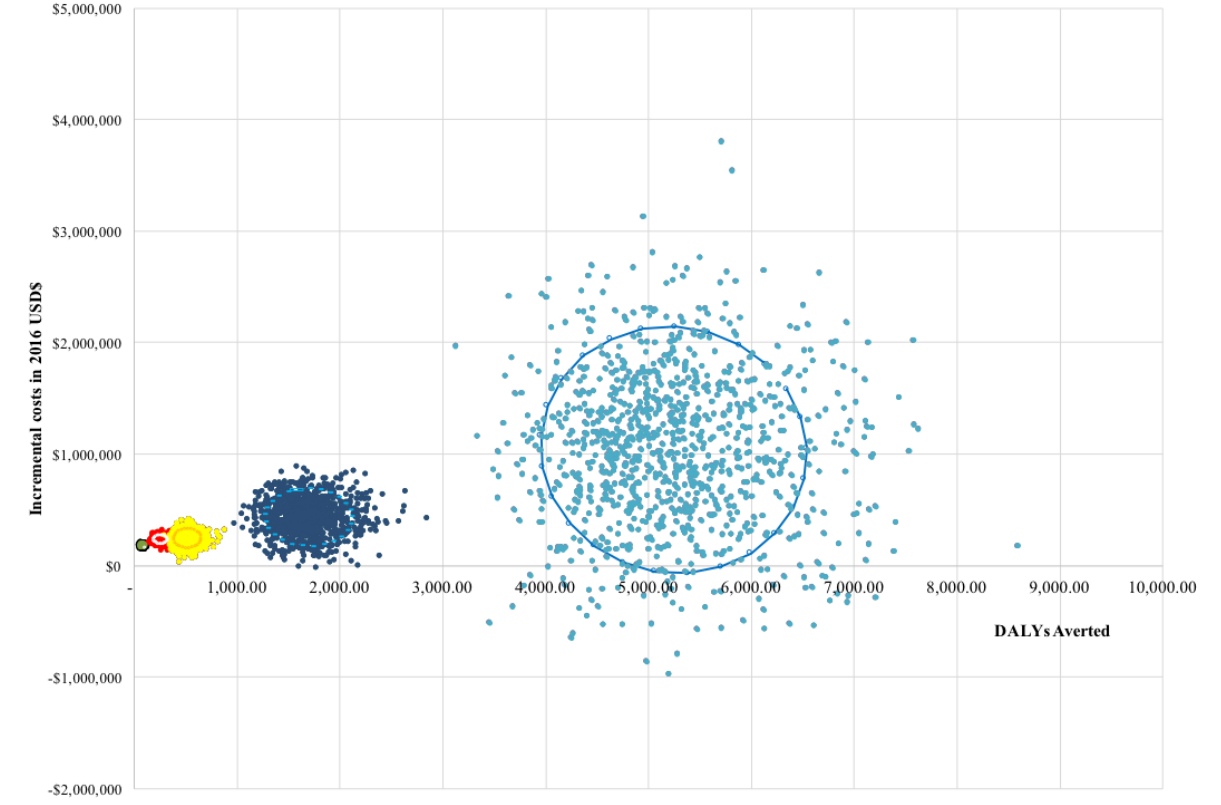
Figure 3. Cost effectiveness plane of years 1-5 of MAMA implementation vs. Status quo in Gauteng, South Africa. Individual dots represent the incremental costs and incremental disability adjusted life years (DALYs) averted for each of 1,000 simulations conducted by year of